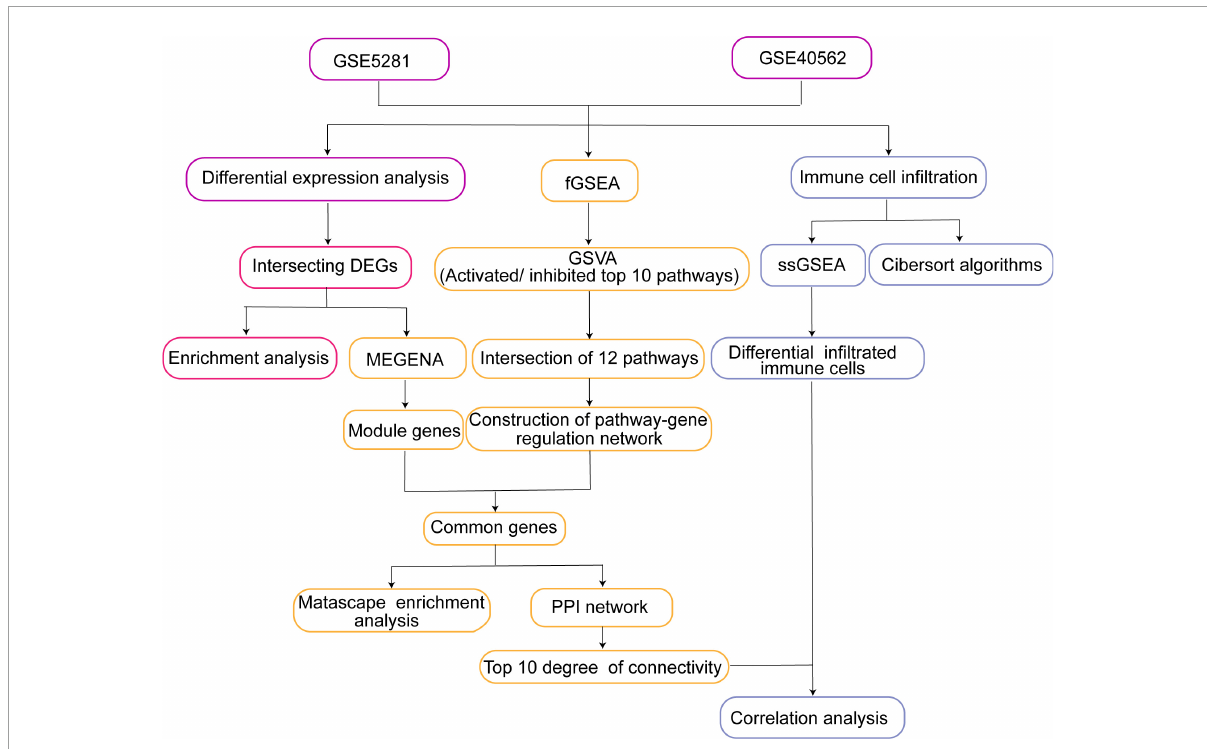
FIGURE1 Study workflow. DEG, differentially expressed gene; fGSEA, fast gene set enrichment analysis; MEGENA, multiscale embedded gene co-expression network analysis; GSVA, gene set variation analysis; PPI, protein-protein interaction; ssGSEA, single-sample gene set enrichment